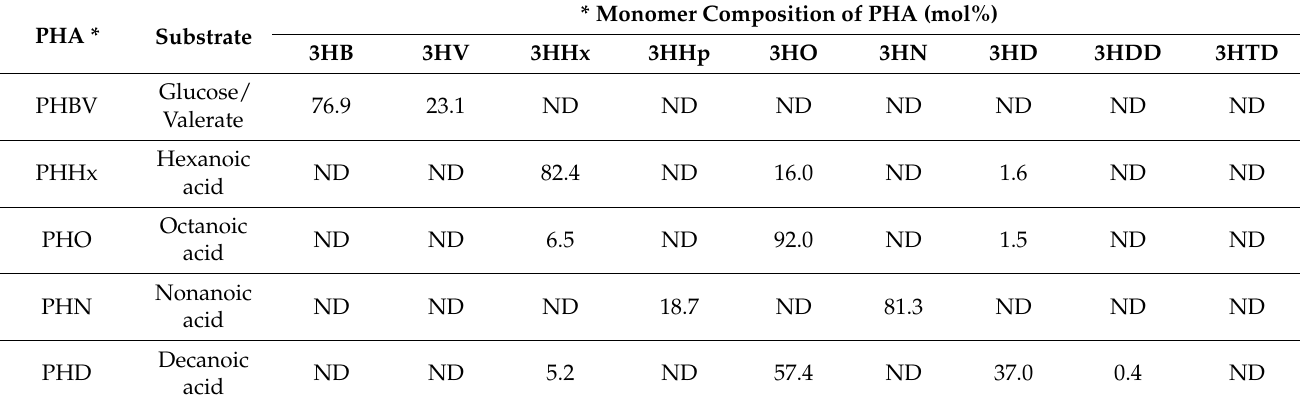
Table 8. Composition of PHA polymers used in this